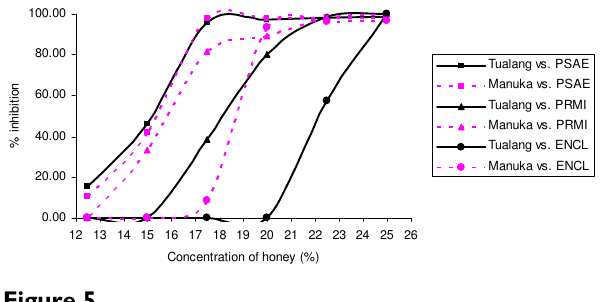
Inhibition of the growth of P. aeruginosa (PSAE), P. mirabilis (PRMI) and E. cloacae (ENCL) Figure 5 mirabilis (PRMI) and E. cloacae (ENCL) .